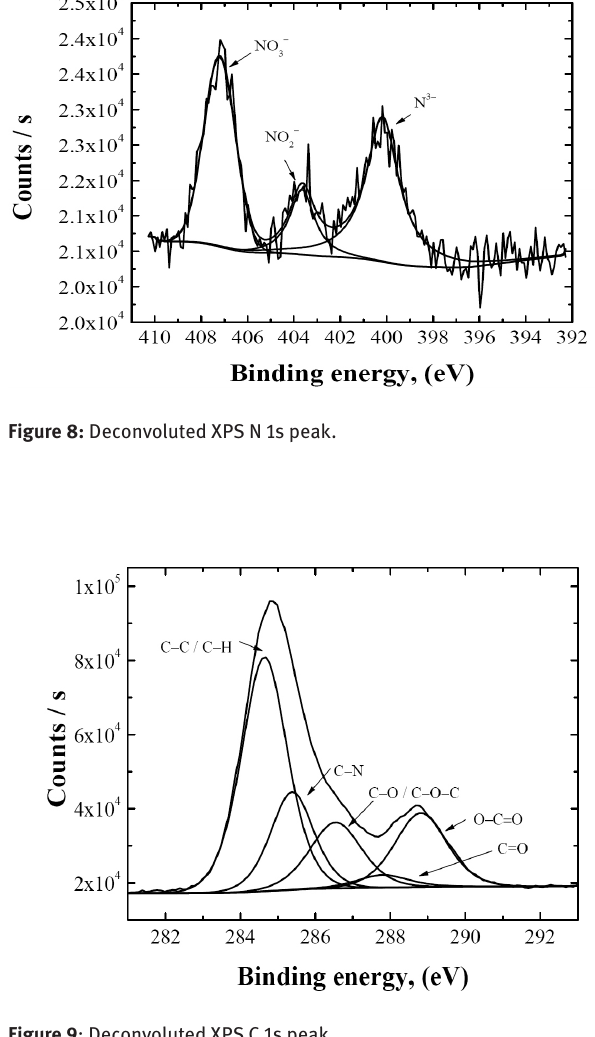
Figure 9 : Deconvoluted XPS C 1s